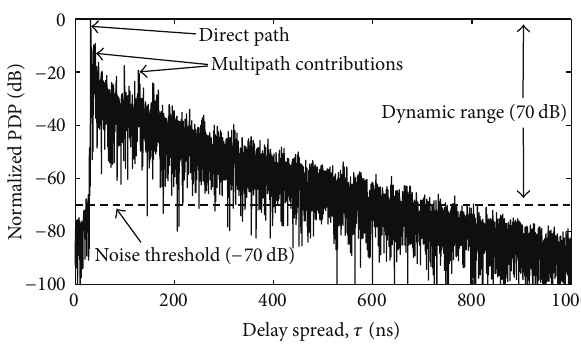
Figure 4: Normalized PDP corresponding to the CIR shown in Figure 3.